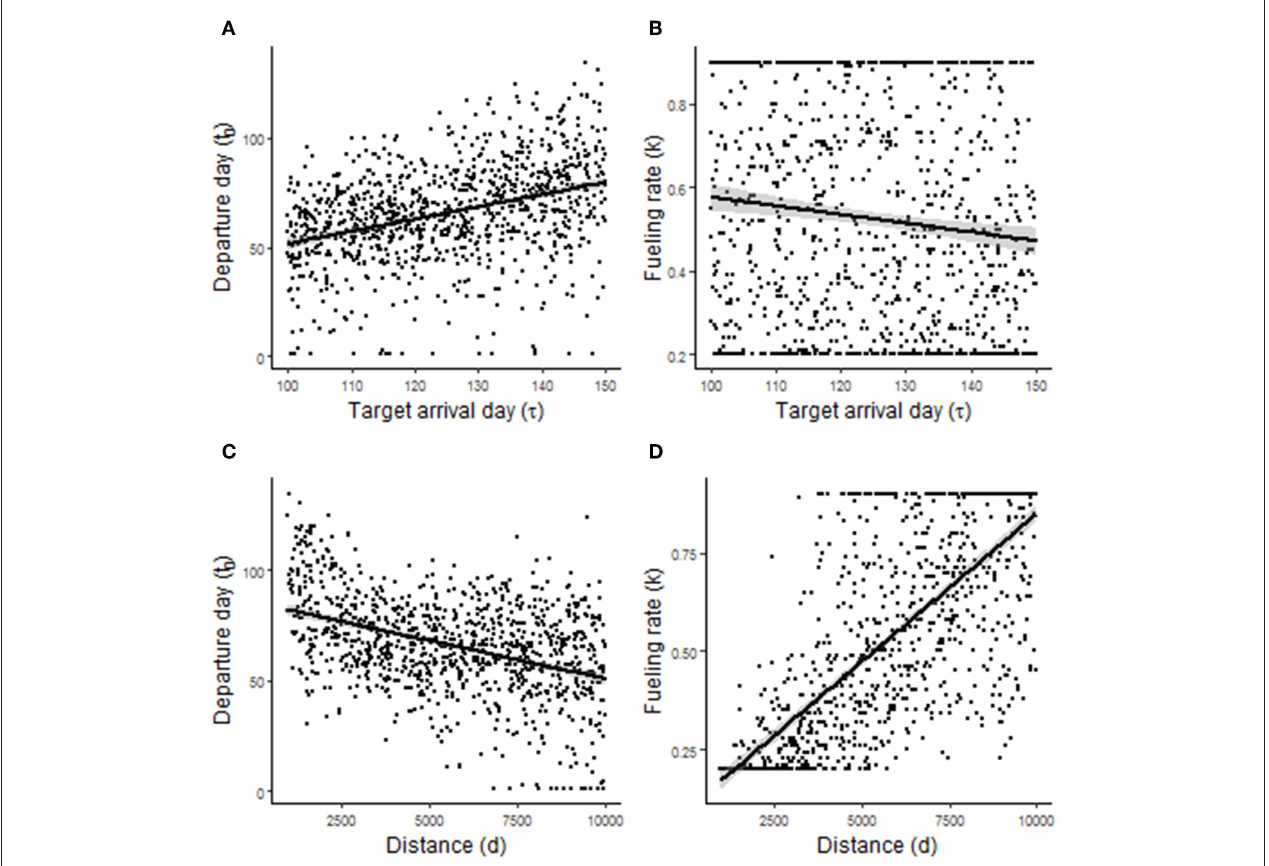
FIGURE 6 | Predictions arising from randomized simulations of migration model 2.2. (A,B) Show the effect of target arrival time τ on departure day of year t 0 and fueling rate k (in W), respectively. (C,D) Show the effect of migration distance d on t 0 , and k , respectively.